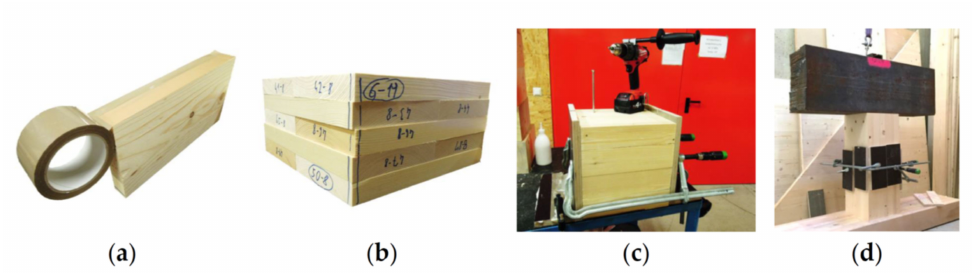
Figure 4. Assembling of specimens exemplarily shown for series 5sCL300 2 : ( a ) application of tape to prevent unintended narrow face bonding; ( b ) dry assembled five-layer CLT specimen before final formatting; ( c ) second step of block gluing of load transmission blocks with fixation by self-tapping screws; ( d ) final assembling of specimen with load transmission blocks on lower and upper side with the dead load